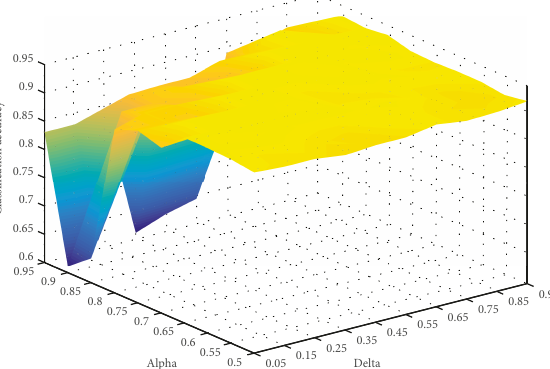
Figure 2: Classi fi cation accuracy with δ and α on wdbc.